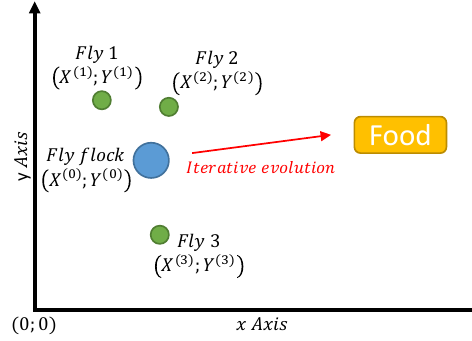
Figure 1. Schematic representation of the FOA